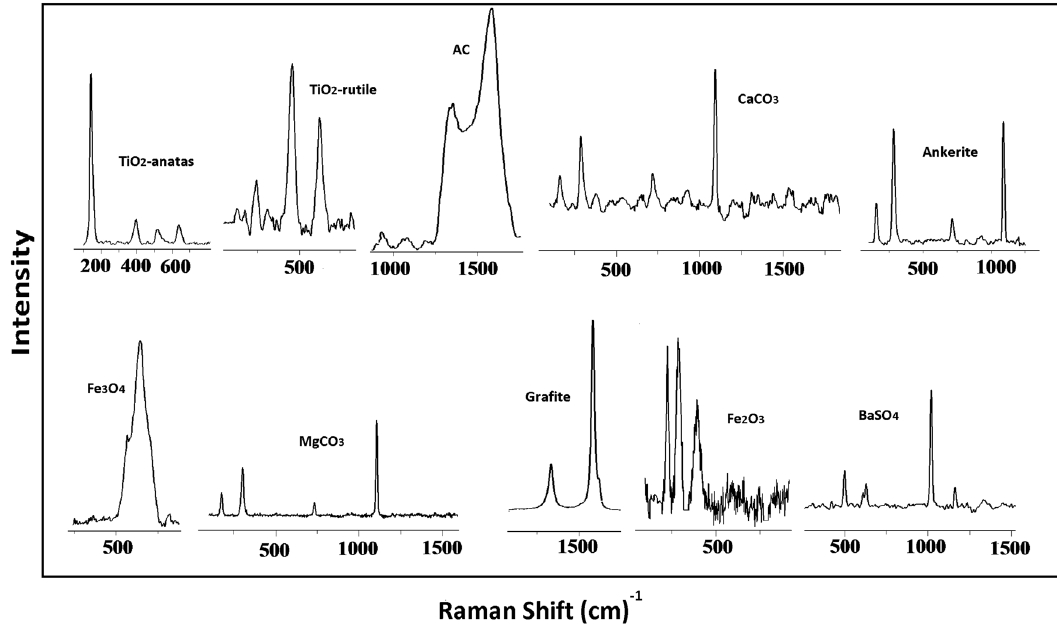
Figure 1. Selected spectra of the compounds found in the hypertrophic tissue samples, measured by Raman microspectroscopy. (TiO 2 -A—anatase, TiO 2 -R—rutile, AC—amorphous carbon, CaCO 3 —calcite, (CaFe(CO 3 ) 2 )—ankerite, Fe 3 O 4 —magnetite, MgCO 3 —magnesium carbonate, GR—graphite, Fe 2 O 3 —hematite, BaSO 4